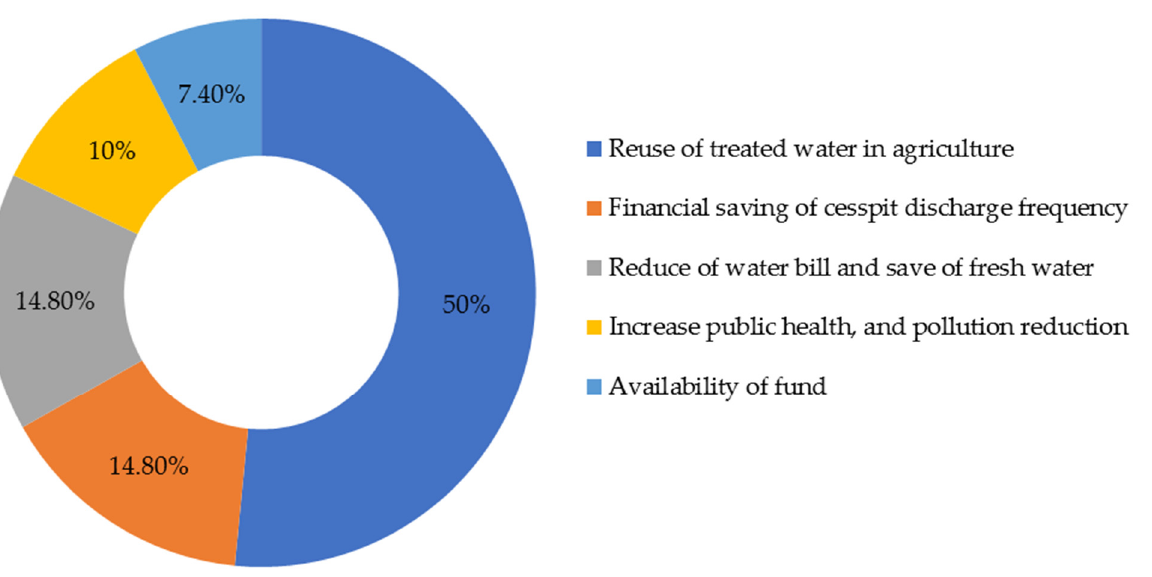
Table 4. Acceptance of using treated gray water in irrigation per governorate.